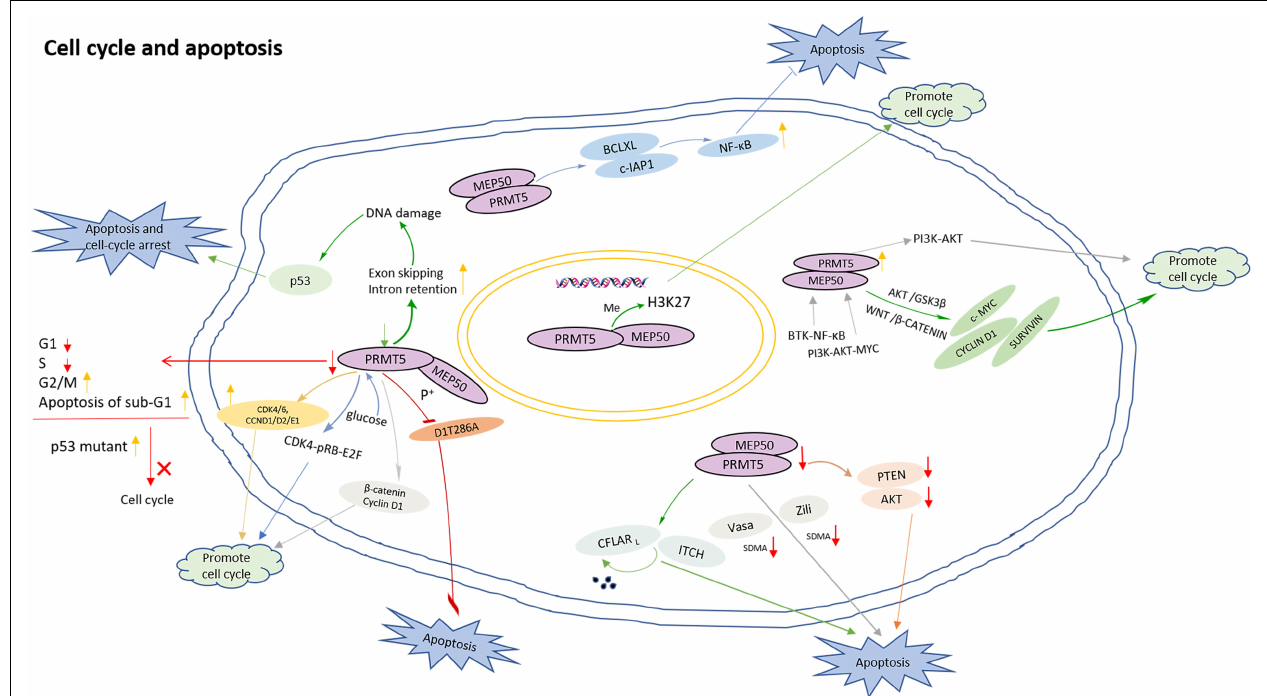
FIGURE 4 | The model for PRMT5 roles in regulation of cell cycle and apoptosis. PRMT5-mediated H3K27 methylation inhibition contributes to cell cycle progression; PRMT5 depletion caused an increase of sub-G1 cells during the DNA damage response; Loss of PRMT5 activity leads to endogenous DNA damage which triggers p53 activation and induces cell apoptosis; Compared with wild-type p53, a p53 mutant compromised in arginine methylation has altered effects on the cell cycle; PRMT5 inhibits cyclin D1T286A-induced apoptosis in a MEP50 phosphorylation-dependent manner; PRMT5 promotes cell cycle progression by up-regulating β -catenin, Cyclin D1, CDK4/6, and CCND1/D2/E1; PRMT5 inhibition resulted in a decrease in the proportion of cells in G1 and S phases, an increase in the proportion of cells in the G2/M phase, and an increase in apoptosis of sub-G1; By influencing the interaction between CFLAR L and ITCH, PRMT5 regulates the polyubiquitination and degradation of CFLAR L , regulating the apoptosis of non-small cell lung cancer cells; PRMT5 interacts with Zili and Vasa, and directly catalyzes the SDMA of Vasa and Zili. The deletion of PRMT5 leads to the dysregulation of the expression of Vasa and Zili, and lead to germ cell apoptosis; When PRMT5 is inhibited, the down regulation of various signal molecules such as Akt and PTEN will induce apoptosis; PRMT5 can stimulate liver glucose metabolism, and activate CDK4-pRB-E2F-mediated transcription under glucose induction to promote HCC cell cycle progression; PRMT5 activates PI3K-AKT signaling and promotes cell cycle